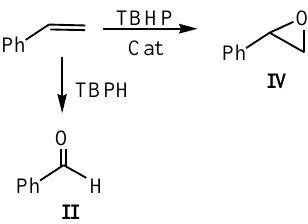
Scheme 2. Transformation of styrene in the presence of TBHP whit 0.08 mmol cat.